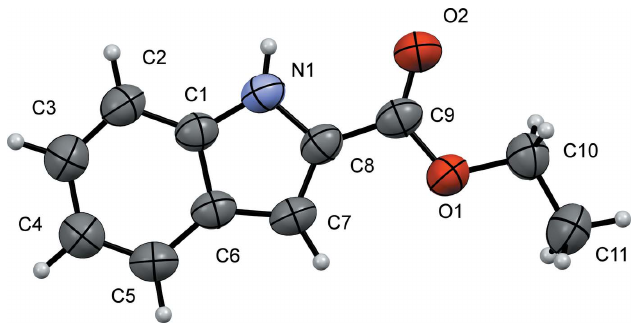
Figure 1 A view of the molecular structure of the title compound, with the atom labelling. Displacement ellipsoids are drawn at the 50% probability level.